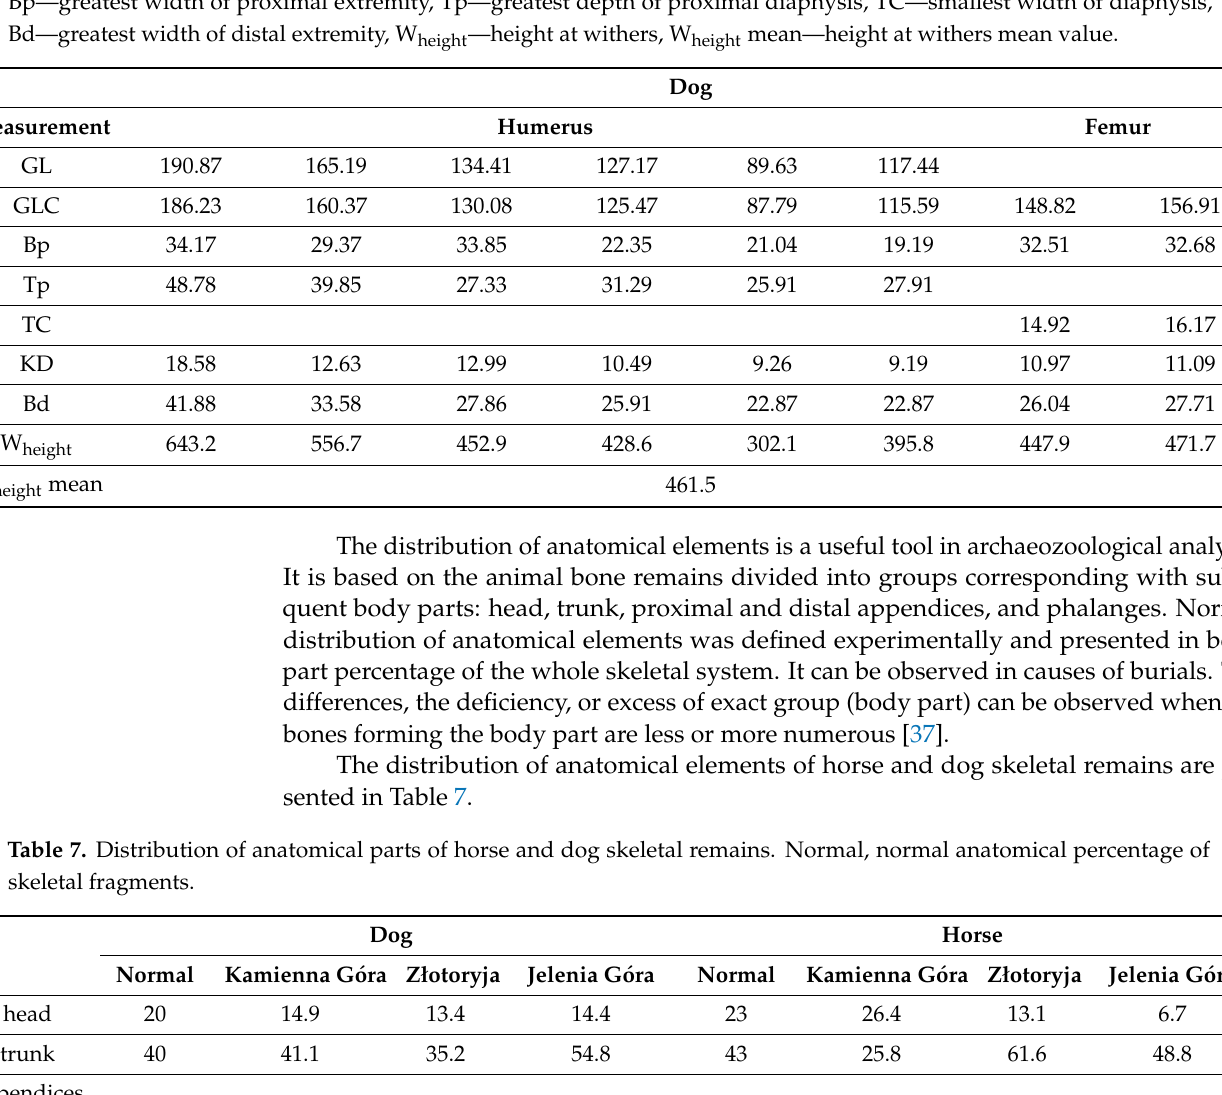
Table 6. The osteometry of measurable dog’s bone remains from Złotoryja with computed height at withers (mm). The abbreviations after A. von den Driesch (1976). GL—greatest length of bone, GLC—greatest length form head of bone,